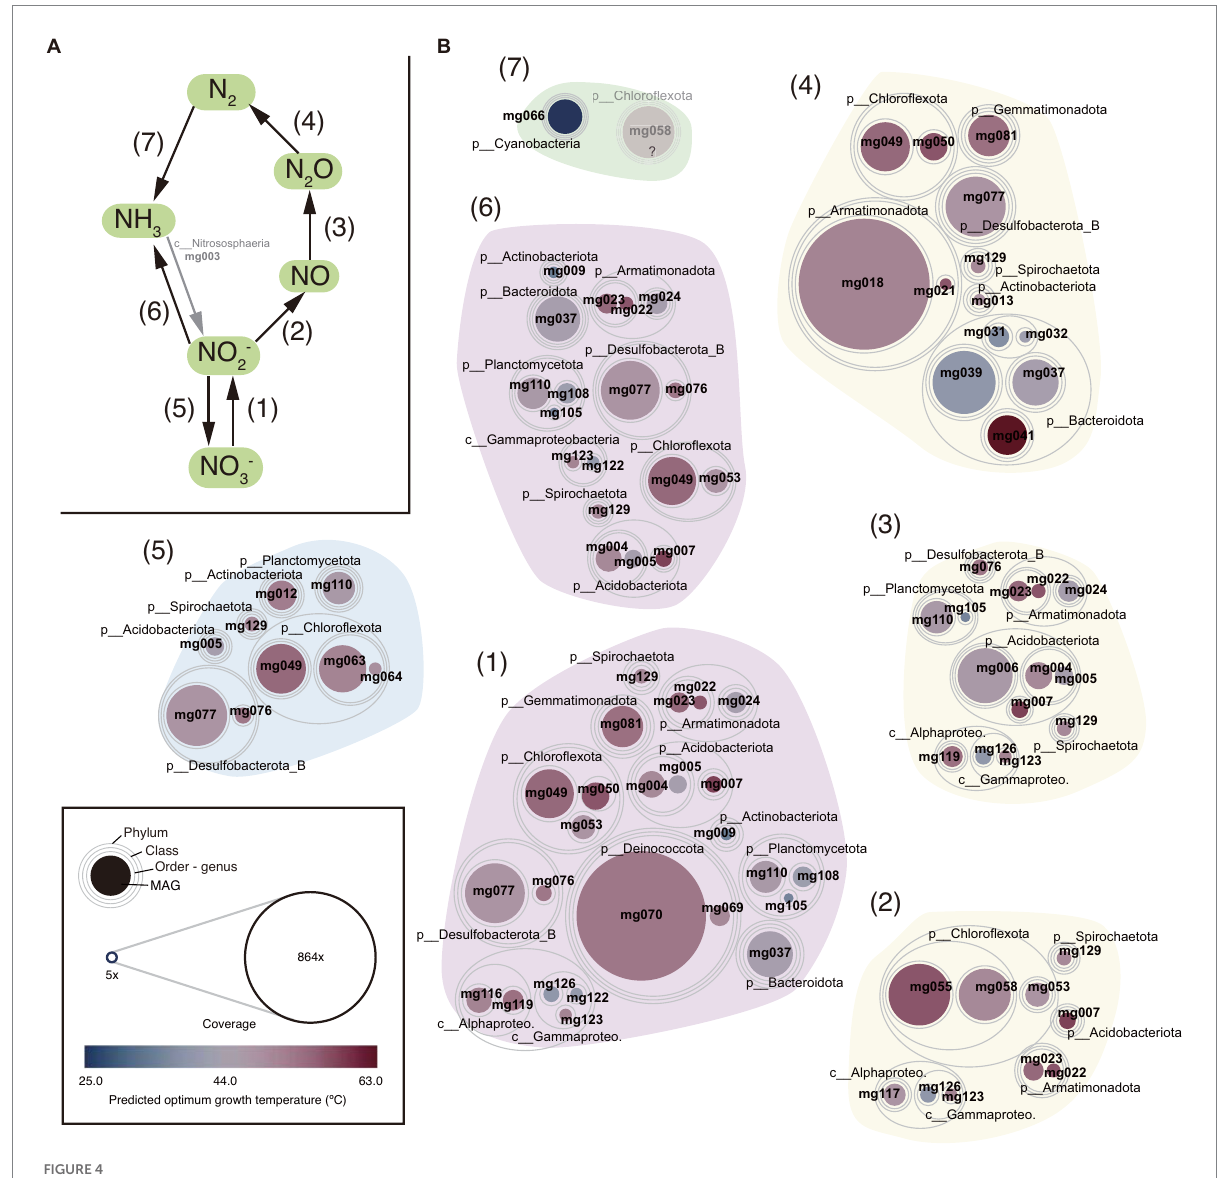
FIGURE 4 MAG-based model of nitrogen cycle. (A) Outline of nitrogen cycle and (B) the 61 HQ MAGs derived from prokaryotes potentially involved in each step (indicated by the numbers in parenthesis). It should be noted that ammonia oxidation to nitrite could be conducted by a Nitrososphaeria archaeon represented by a MQ MAG